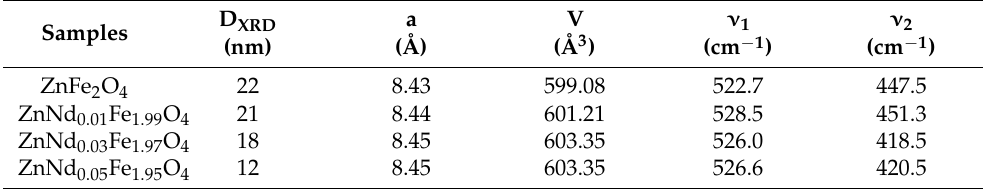
Table 1. Average crystallite size (D XRD ), lattice parameter (a), unit cell volume (V) and wave number, ν 1 and ν 2 for the tetrahedral and octahedral of the ZnNd x Fe 2−x O 4 samples, respectively.